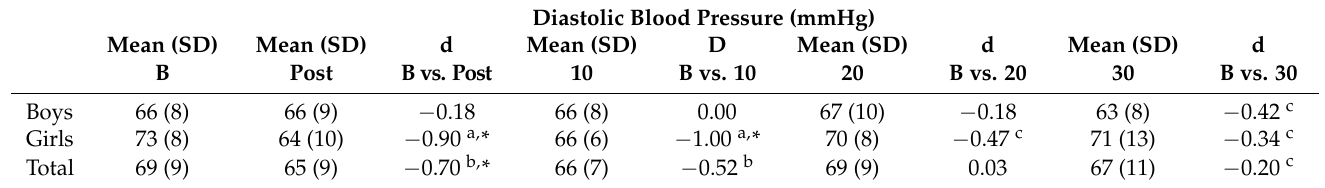
Table 3. Effect of a Muay Thai session on diastolic blood pressure recovery in adolescents with overweight/obesity.